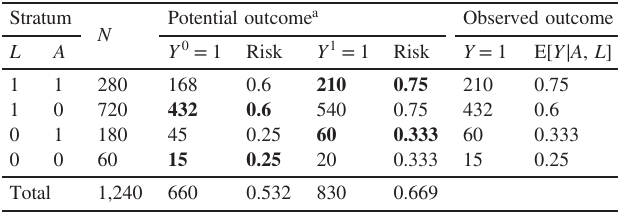
Table 1. Hypothetical cohort data with potential outcomes under point-exposure Stratum Potential outcome a Observed N